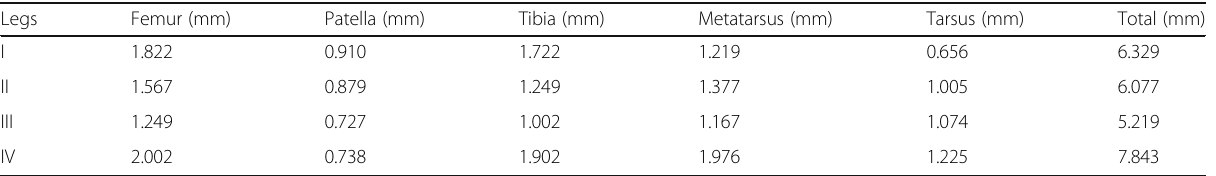
Table 1 Measurements of legs of Pardosa brevivulva Legs